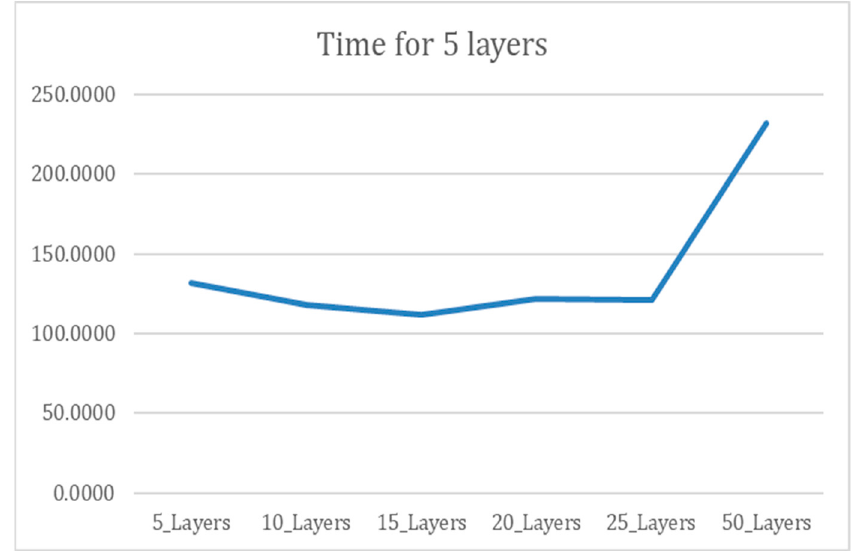
Figure 7. The average run time for every 5 layers in all simulation runs. Table 4. Classified results for all